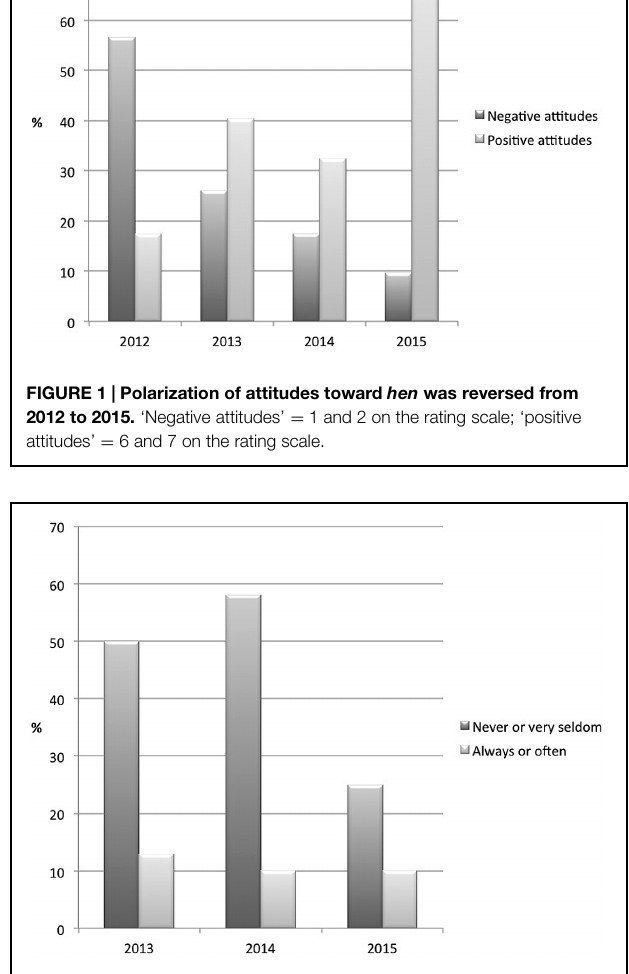
FIGURE 2 | Change in usage of a gender-neutral pronoun from 2013 to 2015. ‘Never or very seldom’ = 1 and 2 on the rating scale; ‘Always, or often = 6 and 7 on the rating